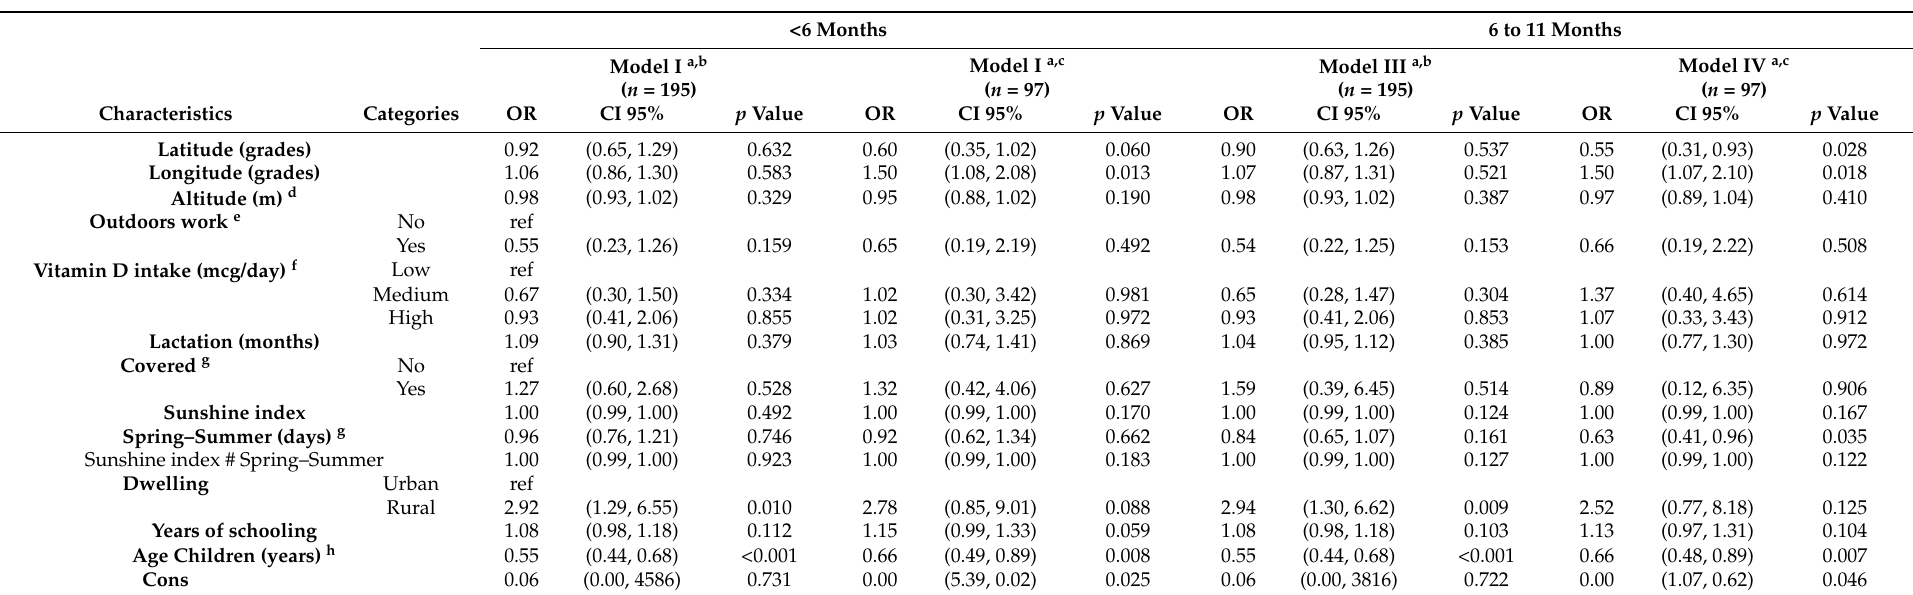
Table 5. Association of retinoblastoma with DF and PF during <6 months and 6 to 11 months of age adjusted by variables of interest.